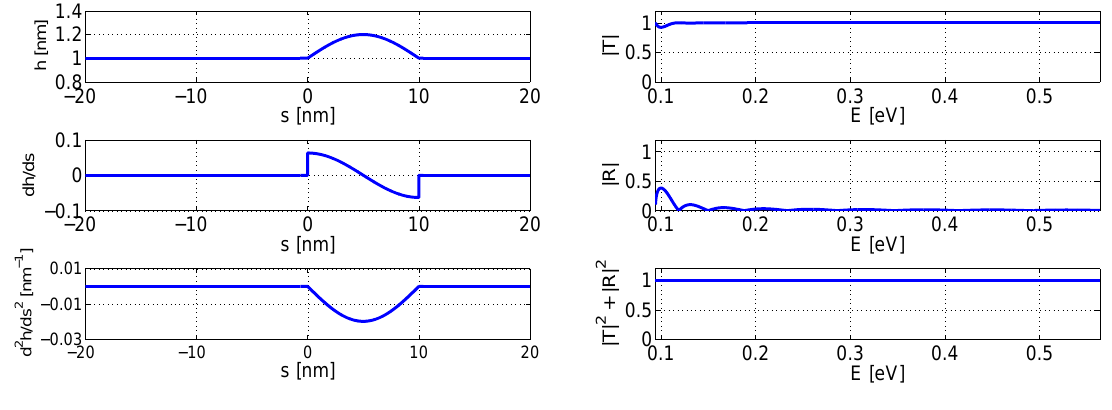
Figure 2. The case h 0 = 1nm, b = 2Å, L m = 10nm, and n = 1, (cid:101) = 1.